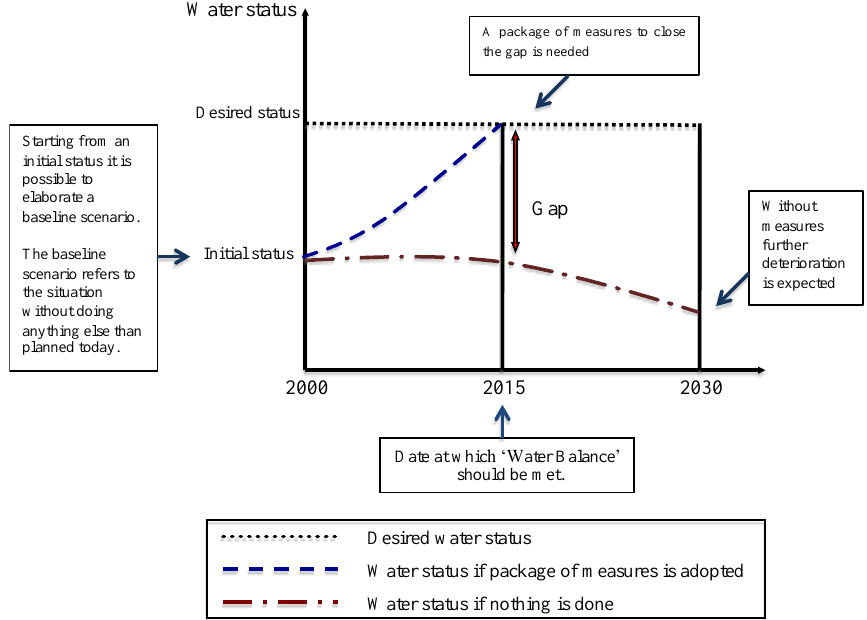
Figure 2. Development of a baseline scenario for assessing future state [18].